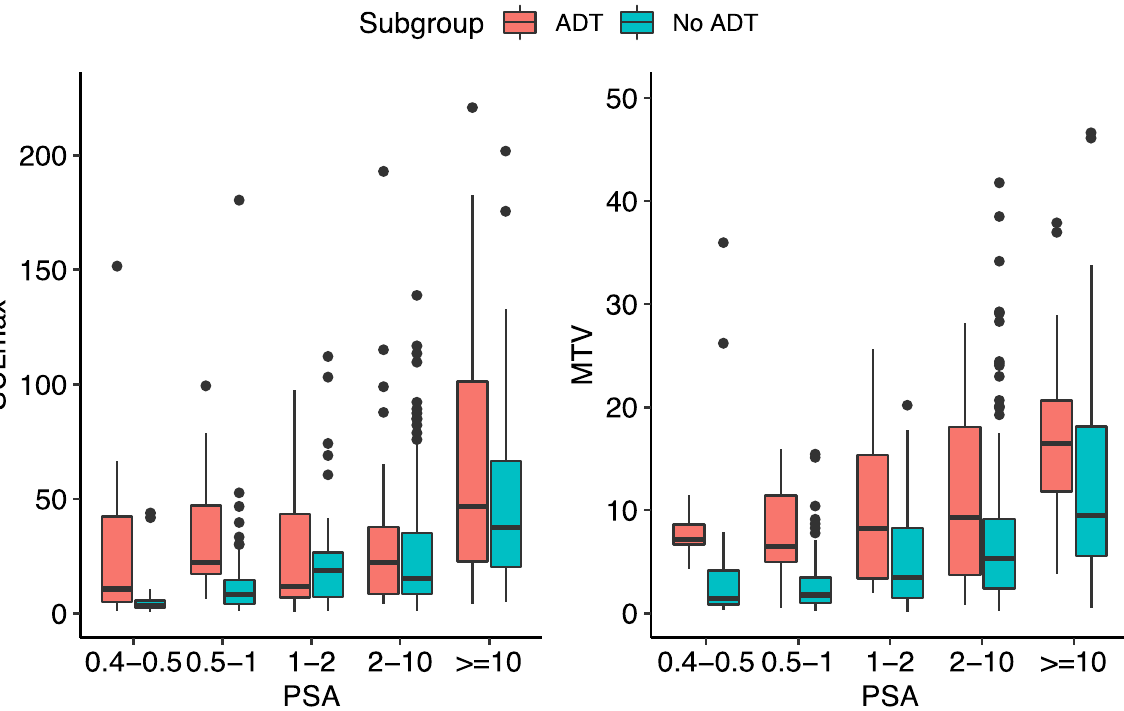
Figure 2. The sum of top five lesions’ SULmax and MTV in different PSA subgroups in patients with/without ongoing ADT at the time of PET/CT.